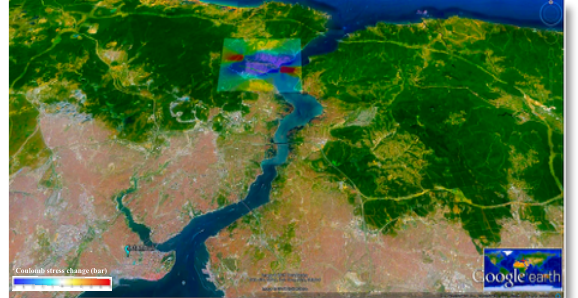
Figure 7: Map of Coulomb stress changes layer displayed on a Google Earth image for 20 October 1999. Model parameters: M w =5.1, Strike = 288°, Dip = 85°, Rake = 146°, Depth = 10km, Time = 00:13 (UCT) and friction coefficient = 0.4. City of Istanbul has been marked on the map. Colour code indicates the Coulomb stress changes; dark blue and red are high stress